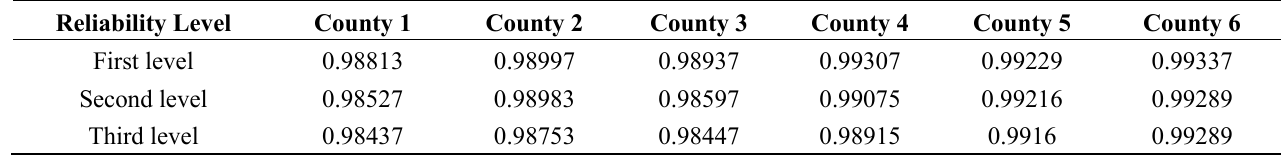
Figure 4. Reliabilities of the samples of six study areas. ( a ) Result reliabilities; ( b ) Process reliabilities. Table 2. Overall result reliabilities of the six study